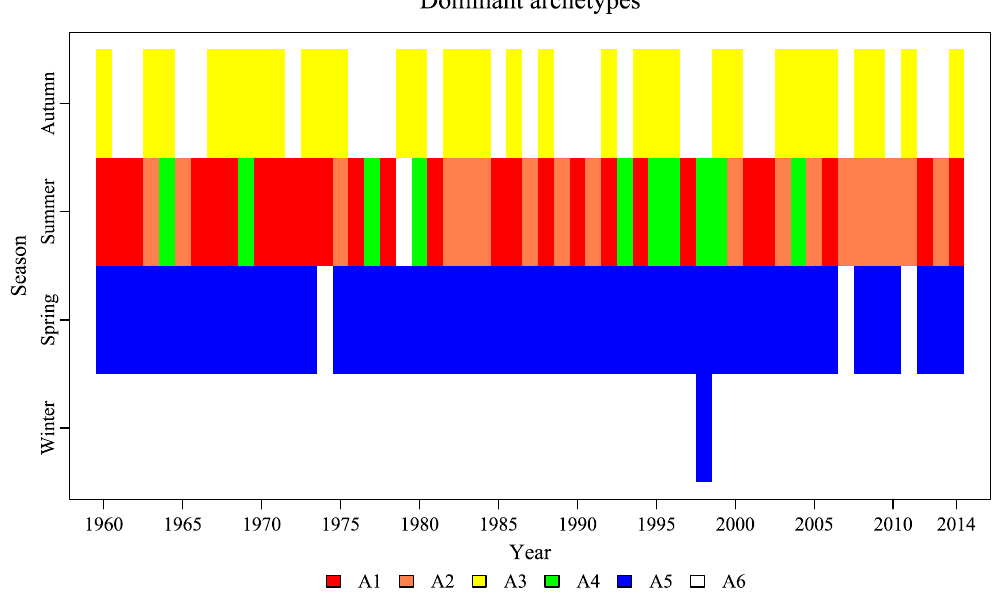
Figure 5. Dominant archetypes for seasonal precipitation across years and seasons. The blank area in the figure represents the seasonal precipitation is dominated by the null archetype A6, relating to the events with little total or no precipitation for that season.